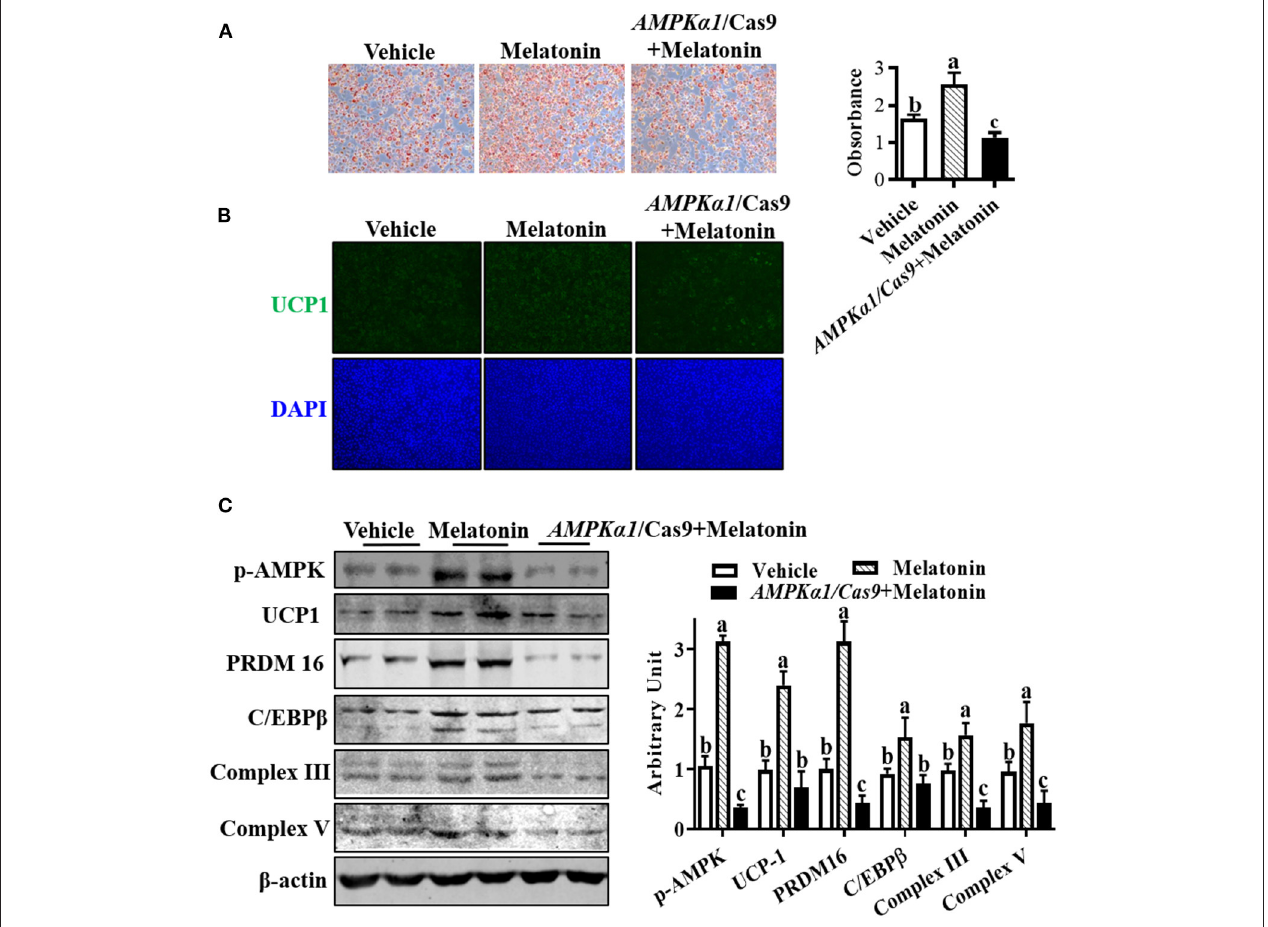
FIGURE 5 | Melatonin facilitated brown adipogenesis through AMPK α 1. Precursor cells were treated with 10nM melatonin or vehicle; simultaneously, AMPK α 1 knockout cells were subjected to 10nM melatonin. (A, B) Brown adipogenesis was evaluated by oil-red O staining (A) and immunocytochemistry staining of UCP1 after 6 days of differentiation (B) . Data showed that the number of brown adipocytes was compromised when AMPK α 1 was knockout. (C) The p-ACC, UCP1, PRDM16, C/EBP β , complex III, and complex V protein contents among different groups ( n = 6, mean ± SEM; different letters mean significant